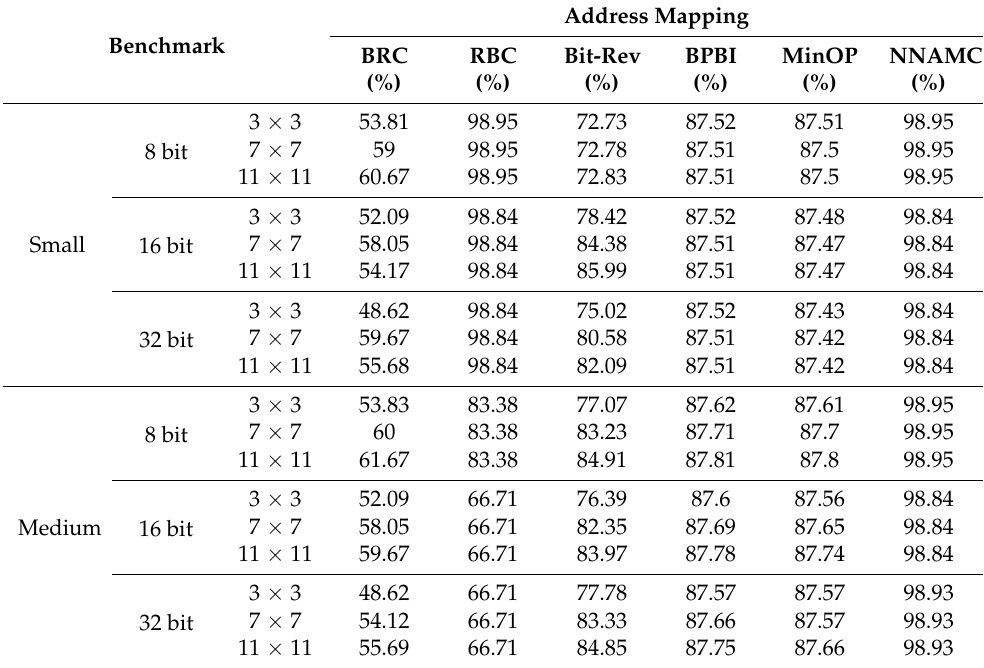
Table 2. Comparison of row buffer hit ratios of different address